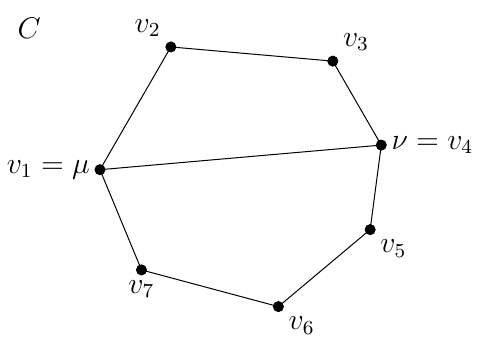
Figure 1: Here e ∗ = { v adjacent vertices of the cycle C = { v